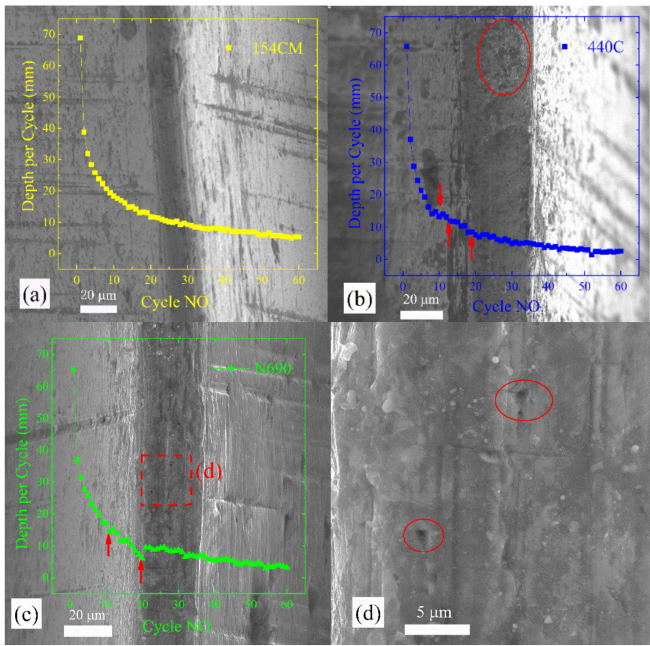
Figure 9. Surface of blade edge made of stainless steel 154CM ( a ), 440C ( b ), and N690 ( c , d ) after sharpness test overlapped with characteristic cutting depth per cycle for the corresponding steel